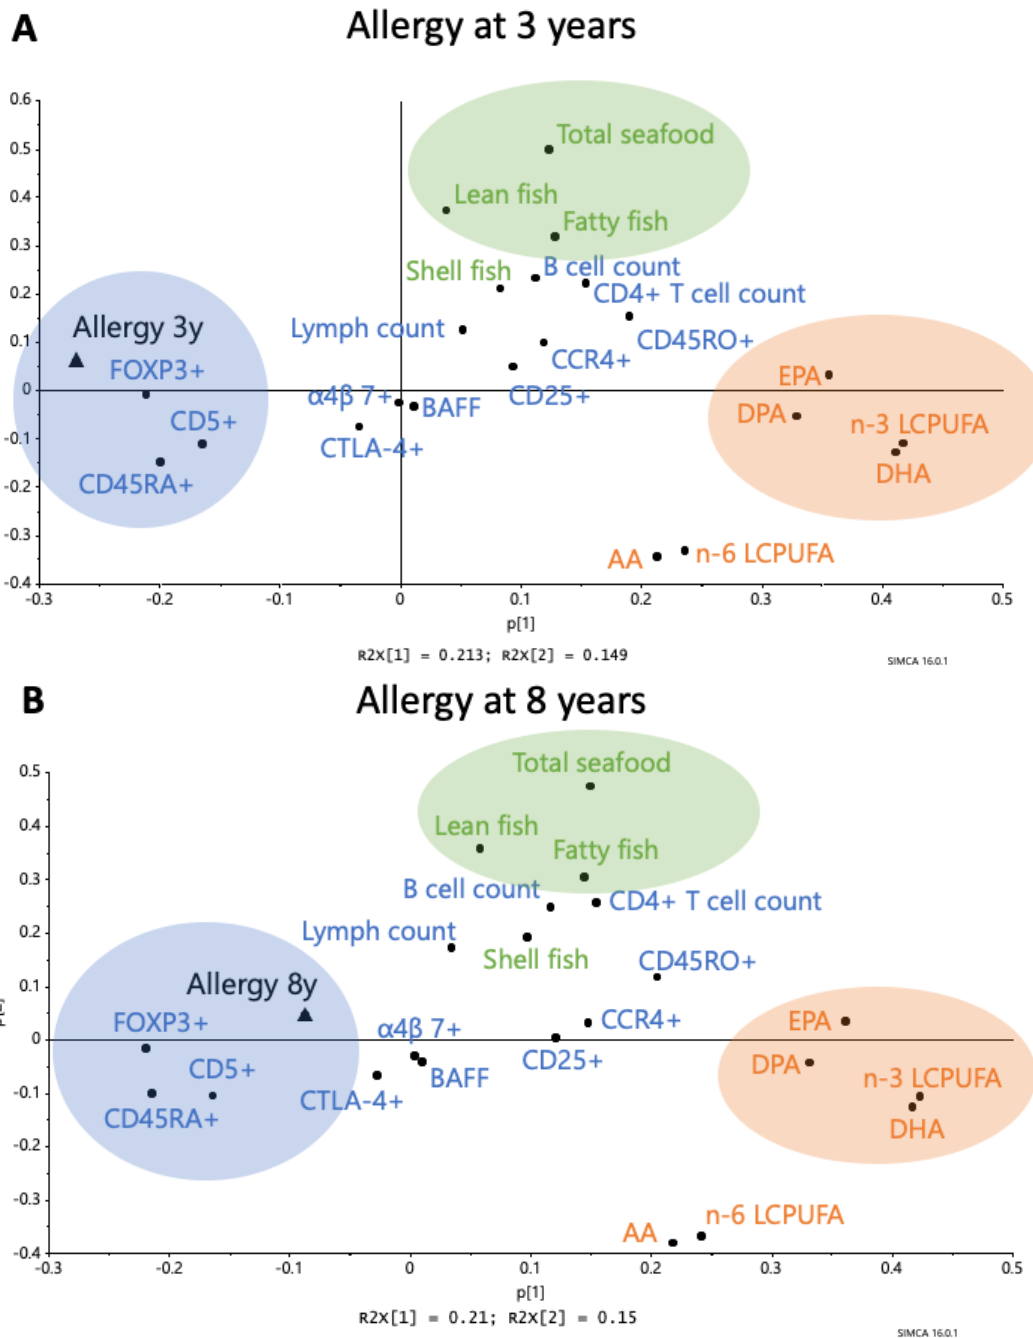
Figure 2. Principal Component Analysis (PCA) loading plot showing the associations between maternal fish intake during pregnancy, LCPUFAs (EPA, DHA, total n-3 LCPUFAs, AA, and total n-6 LCPUFAs) in the cord serum, circulating B cells (B cell count, CD5 + ) and CD4 + T cells (CD4 + T cell count, activated CCR4 + , activated CD25 + , memory CD45RO + , naïve CD45RA + , naïve α 4 β 7 + , CTLA4 + CD25 + , FOXP3 + CD25 high ) in umbilical cord blood, and B cell activating factor (BAFF) in the cord plasma and allergy at 3 years of age ( A ) and 8 years of age ( B ). Abbreviations: 3y, 3 years; 8y, 8 years, AA, arachidonic acid, EPA, eicosapentaenoic acid; DPA, docosapentaenoic acid; DHA, docosahexaenoic acid; LCPUFA, long-chain polyunsaturated fatty acids. All 65 infants in the FARMFLORA cohort were included in the